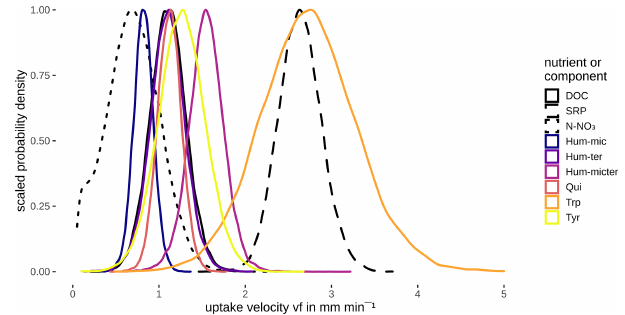
Figure 6. Posterior density distribution curves of uptake velocity v f for different compounds and